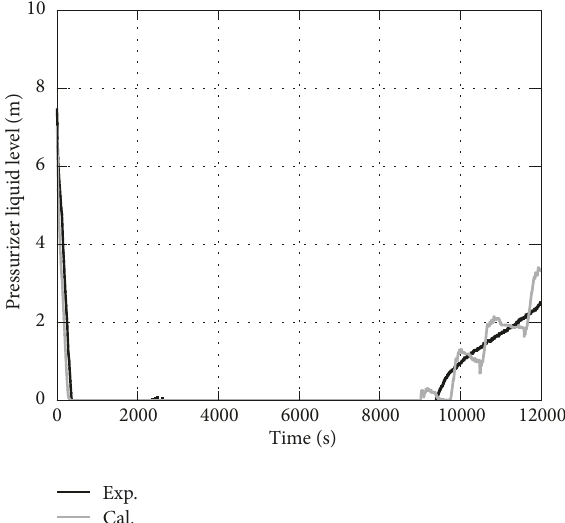
Figure 21: TR-LF-17 test and RELAP5 results for PZR liquid level.